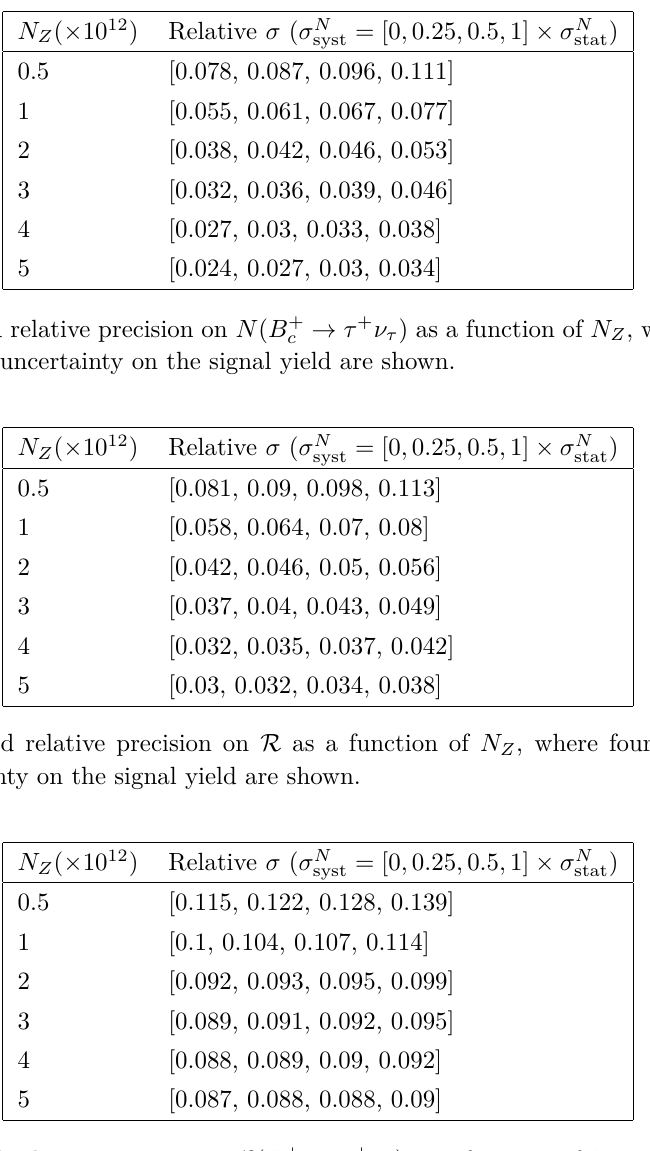
Table 5 . Estimated relative precision on B ( B + levels of systematic uncertainty on the signal yield are